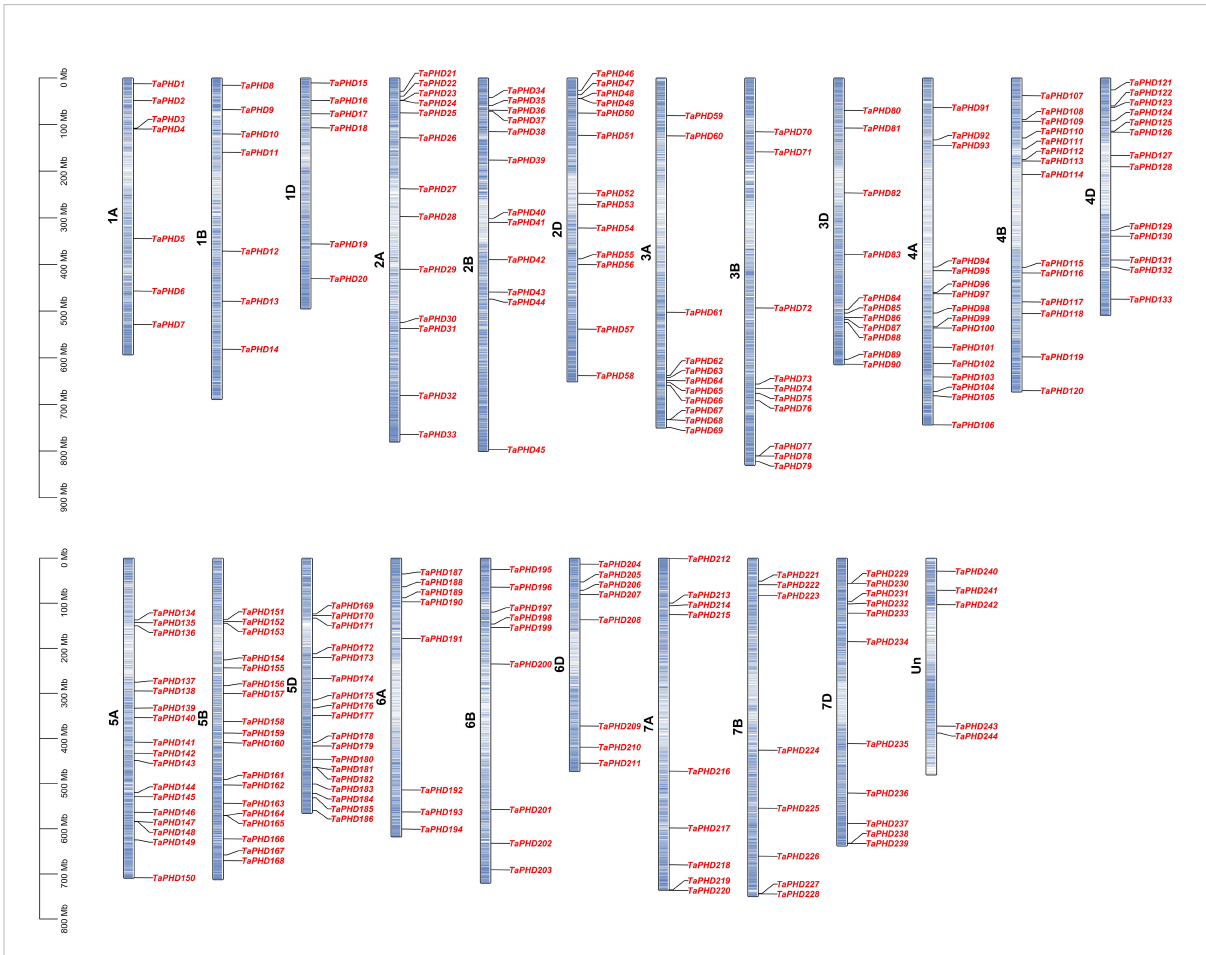
FIGURE 5 Synteny analysis of PHD genes between wheat and six representative plants (maize, barley, rice, Arabidopsis , cotton, and Brassica rapa ). Each different species is replaced with a different color. The gray line in the background indicates a collinear block in the genome of wheat and other plants, while the line highlights the isomorphic PHD gene pair. Homoeologous PHD genes were inferred by phylogeny (for details see the Materials and Methods section) and linked with chromosome-speci fi c